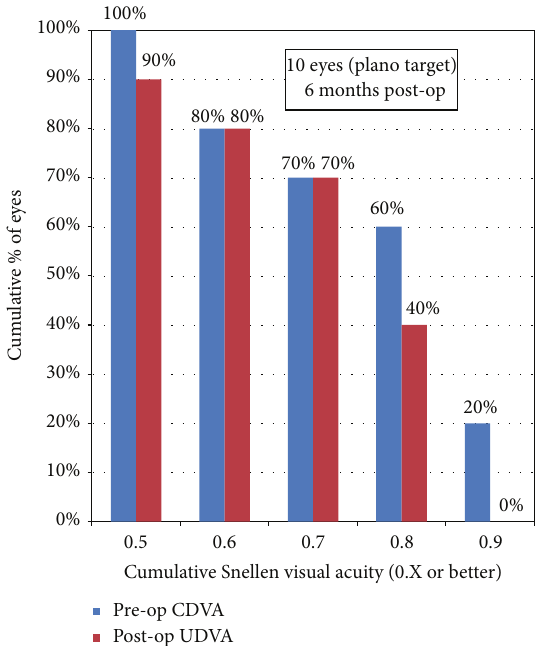
Figure 7: Uncorrected distance visual acuity 6m postoperatively.